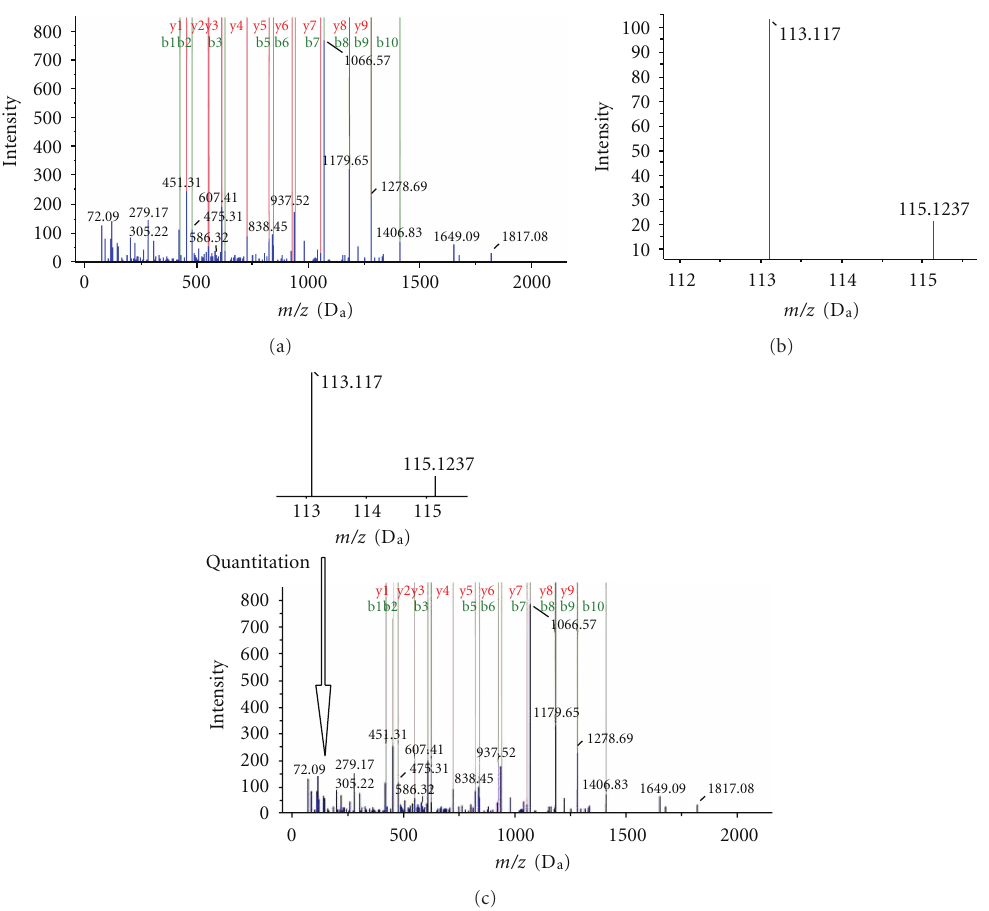
Figure 1: The fragment ion spectra of peptide sequence tag (PST) from CKB protein, highlighting the relative abundances of overexpression in NHBE. The ion assignments are as follows: 113: NHBE; and 115: